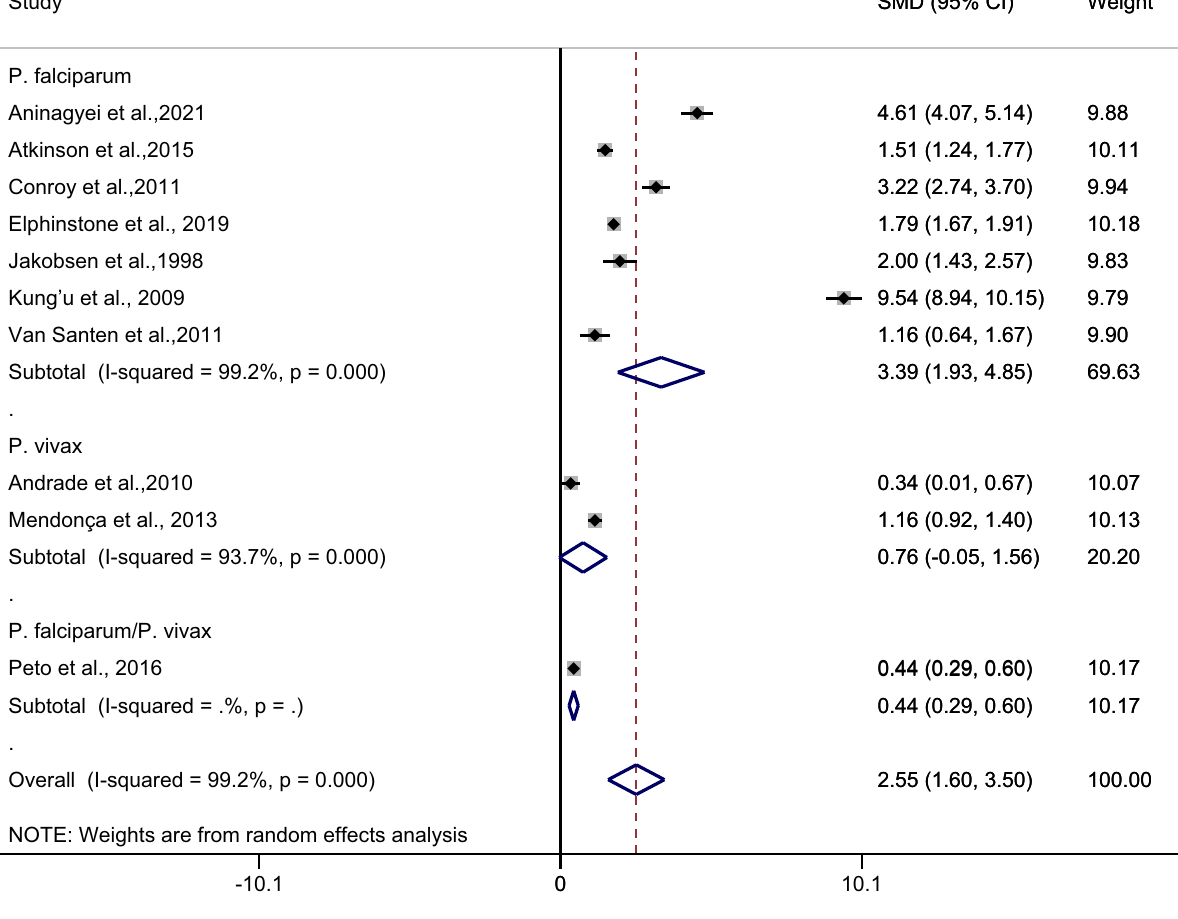
Figure 11. Forest plot demonstrates the difference in the mean CRP level between patients with asymptomatic malaria and healthy/febrile controls by types of infections. SMD, standard mean difference; CI, confidence interval.